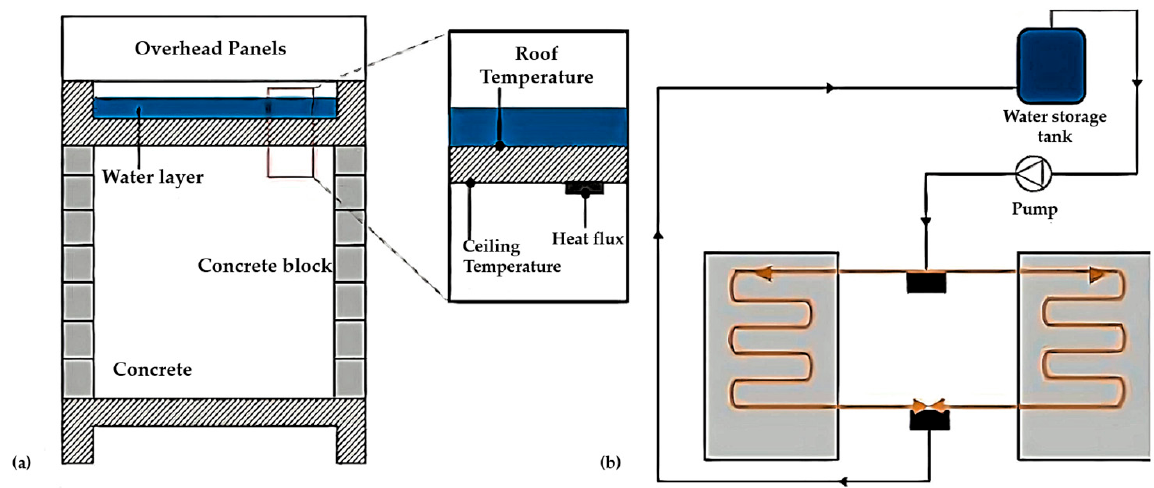
Figure 14. ( a ) Open-loop cooling system [90] and ( b ) Closed-loop cooling system